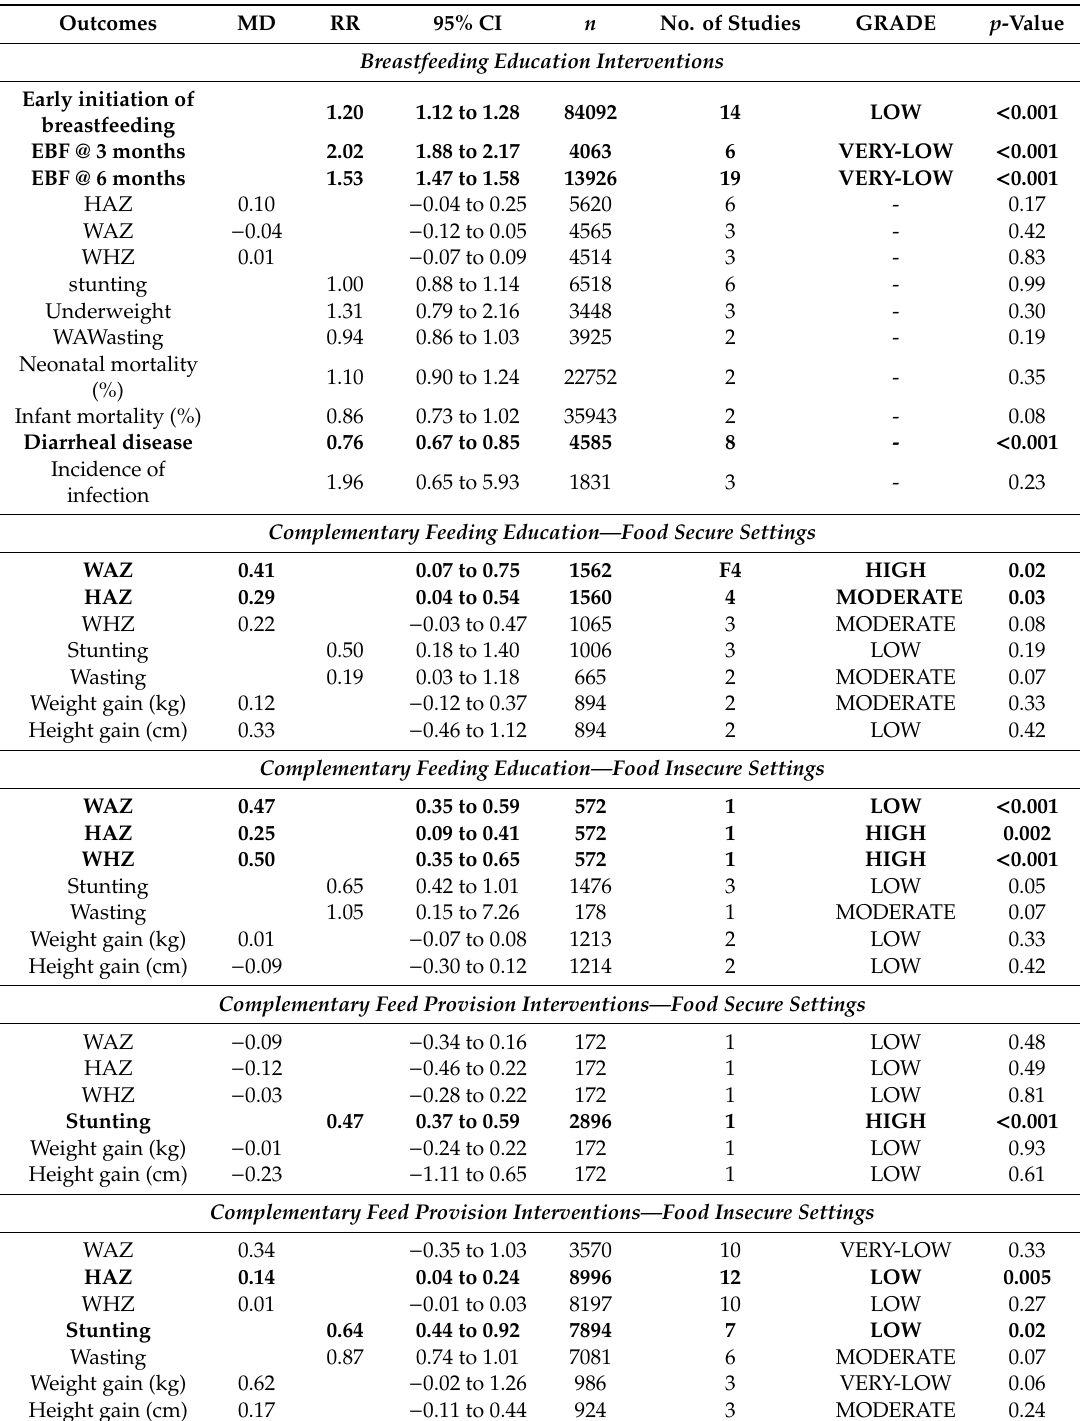
Table 1. Estimates of e ff ect of the interventions and